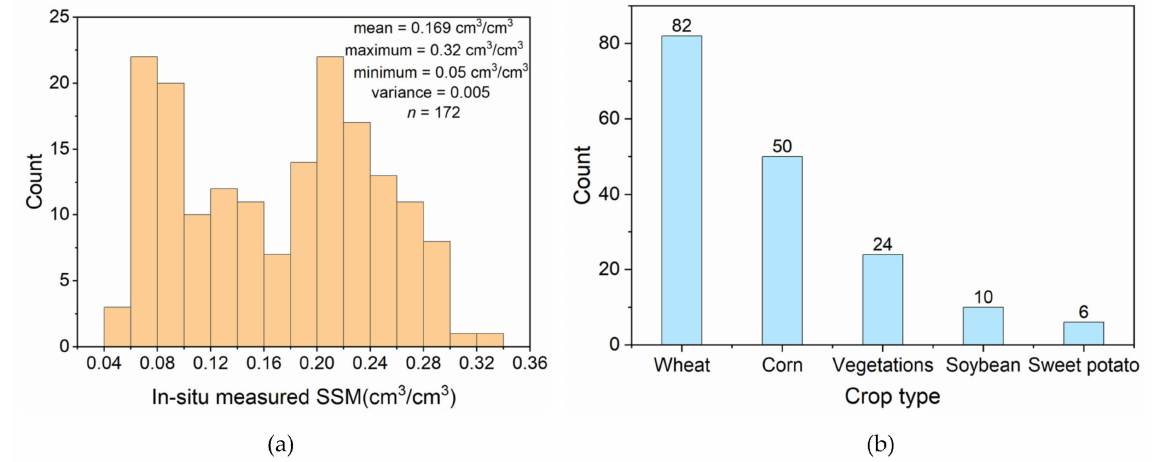
Figure 3. Statistics of in situ measured SSM: ( a ) distribution of in situ measured SSM; ( b ) in situ measurements for different crop